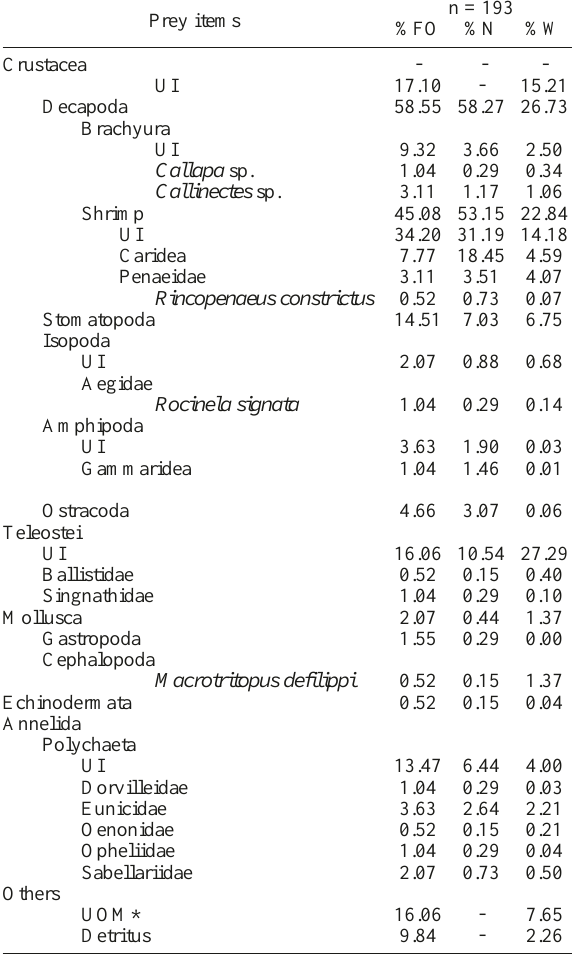
Table 1. – Contribution of each prey item for the overall diet of P. maculatus by frequency of occurrence (%FO), number (%N) and weight (%W). (UOM*, unidentified organic matter; UI, unidentified).